Question: Condense the content of this figure into a single sentence.
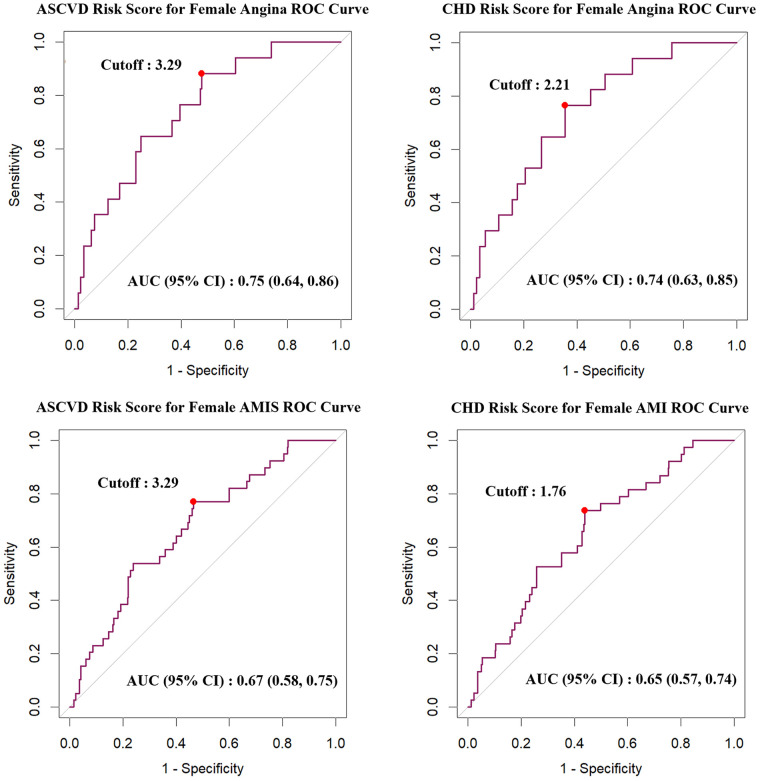
Answer: ROC curves of different PREVENT equations risk scores. AMI, angina and myocardial injury; AMIS, angina, myocardial injury and stroke; ASCVD, atherosclerotic cardiovascular disease; CHD, coronary heart disease.